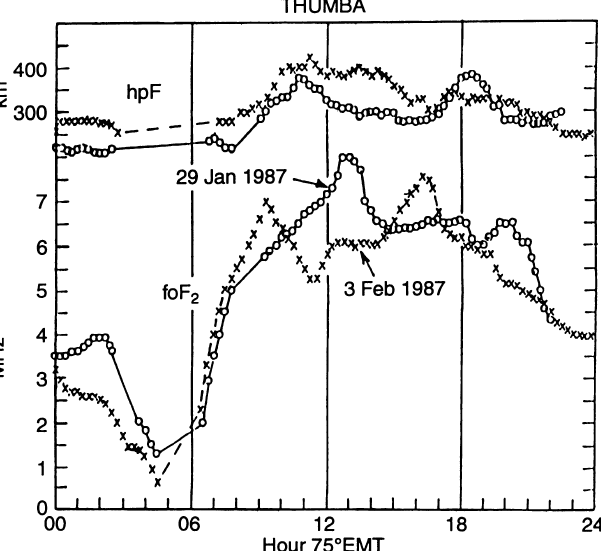
Fig. 11. Solar daily variations of the critical frequency, f layer and the height of the peak electron density hpF of the F region at Thumba on the normal electrojet day (3 February, 1987) and on counter electrojet (29 January,